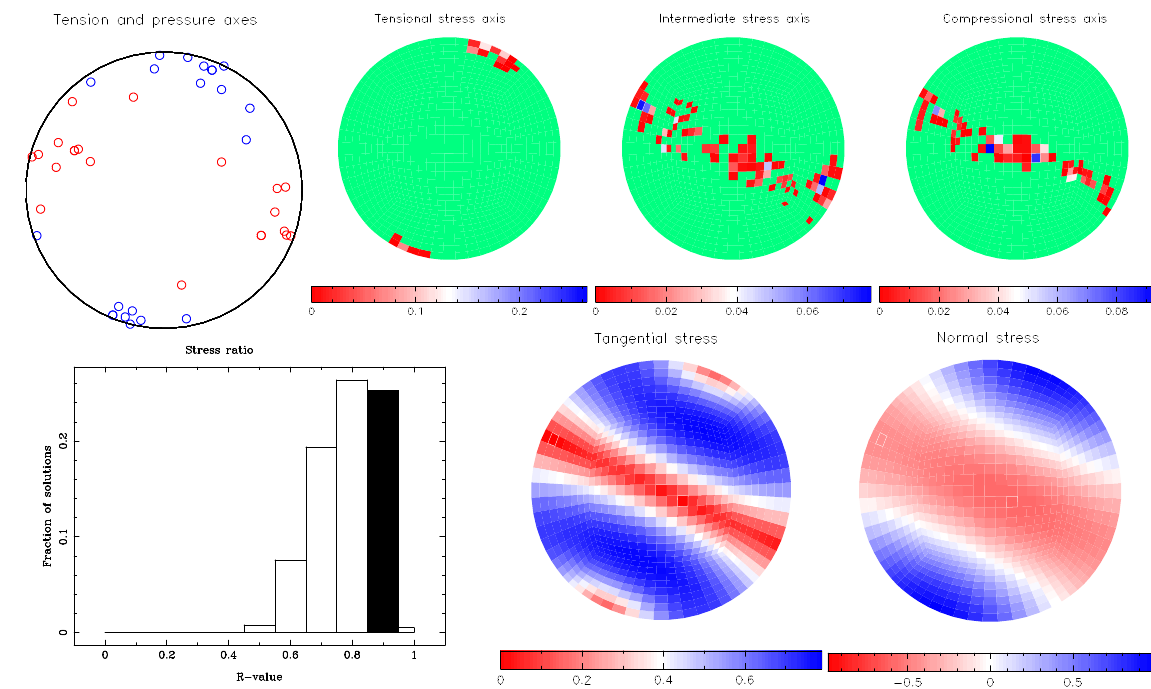
Fig. A5. Results of stress inversion for cluster of shallow earthquakes near Sigacik. Explanation of subfigures is as in Fig. 5. 24 W. Friederich et al.: Focal mechanisms and stress field in the Southern Aegean